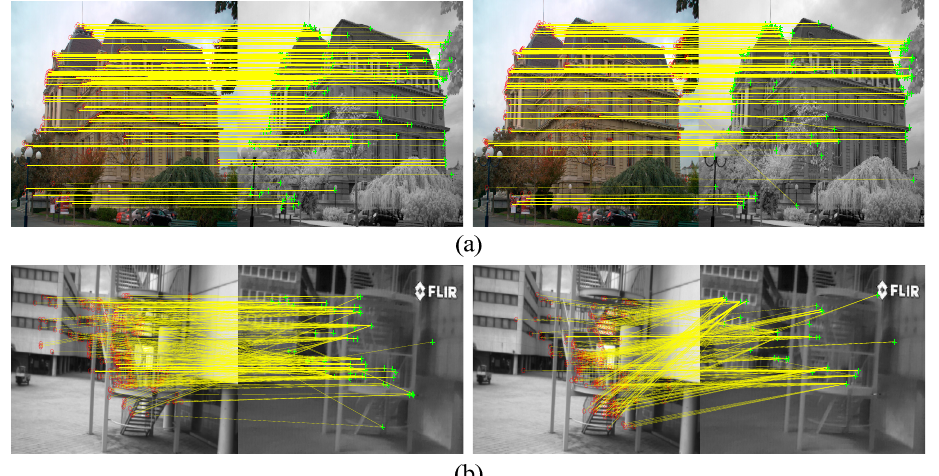
Figure 9. Comparisons of matching results between the HOSM descriptor and the descriptor without guided filtering. The left column is the matching results of the HOSM descriptor, and the right column is the matching results of the descriptor without guided filtering. From top to bottom: matching results on ( a ) EPFL (VIS/NIR) dataset and ( b ) CVC (VIS/LWIR) dataset. Table 1. Precision, recall and F1-score for HOSM and descriptor without guided filtering.